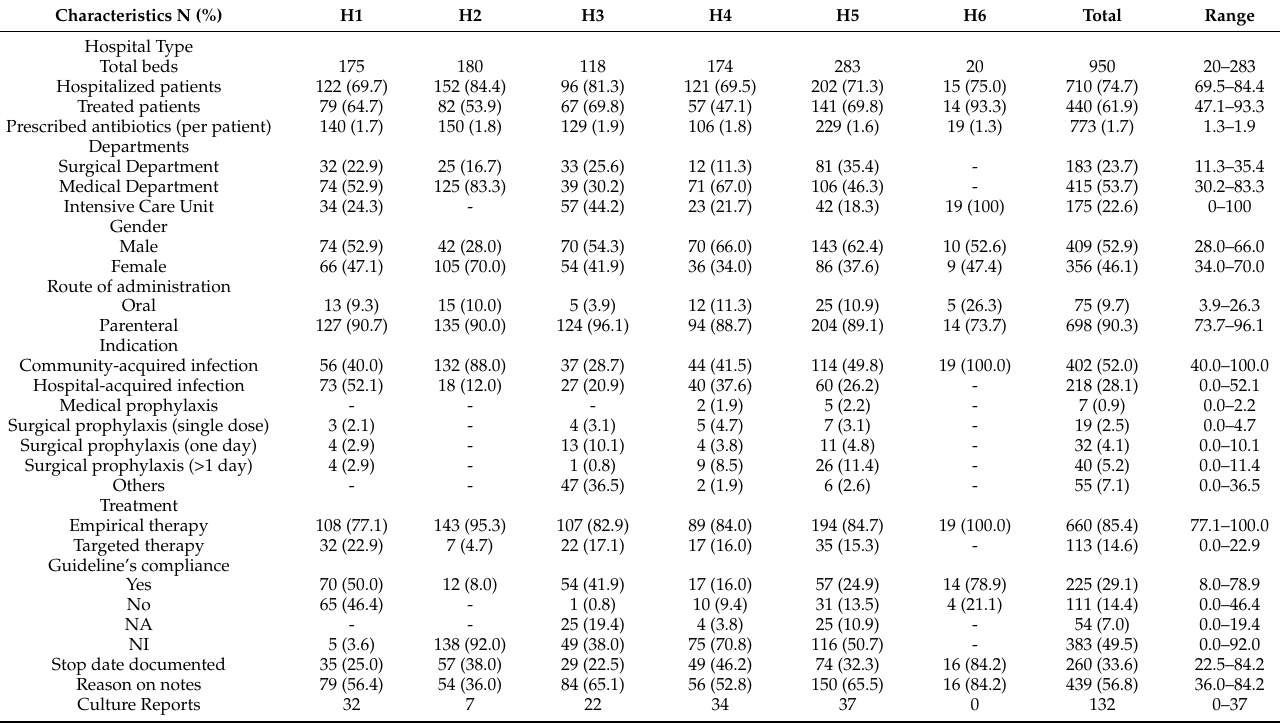
Table 1. Overall antibiotic use prevalence.